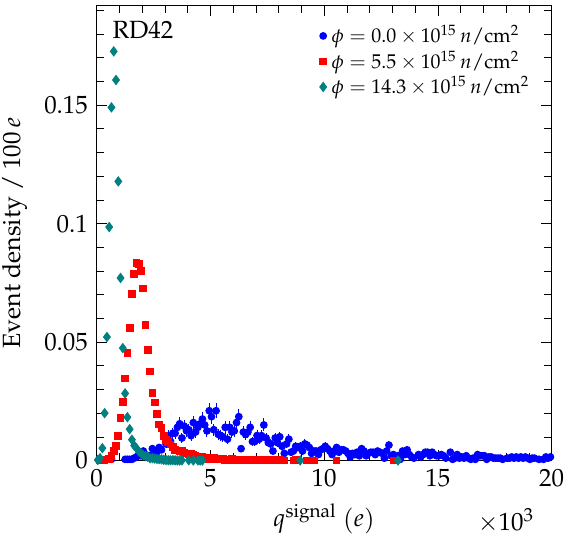
Figure 3. The signal charge spectrum evolution for samples irradiated with fast neutrons biased at 2V/µm. The pulse height spectrum before irradiation was measured using a setup with a 90 Sr E = − β -source and a single pad metallization on the diamond. The integral of each spectrum was normalized to